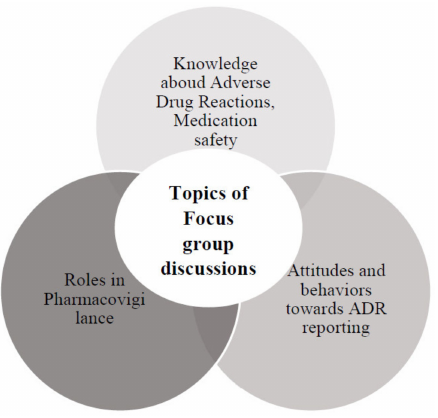
Figure 1. Summary of topic guides for focus group discussions.